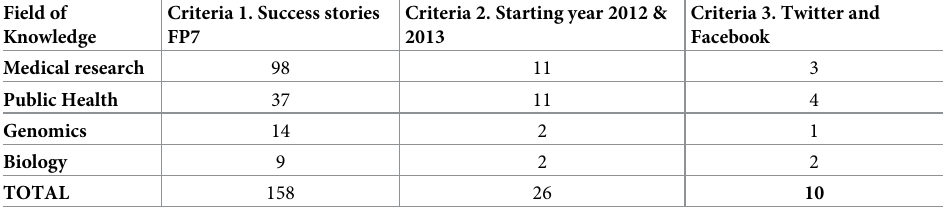
Table 1. Selection criteria and number of